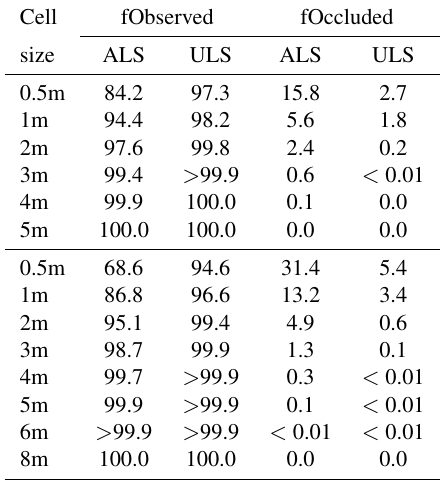
Table 1. Observation statistics for site 1 (top) and site 2 (bottom), stating the fraction of observed voxels ([%], fObserved ) and the fraction of occluded voxels ([%], fOccluded ). The voxels have a squared ground area with side length stated by Cell size and a constant voxel height of 1